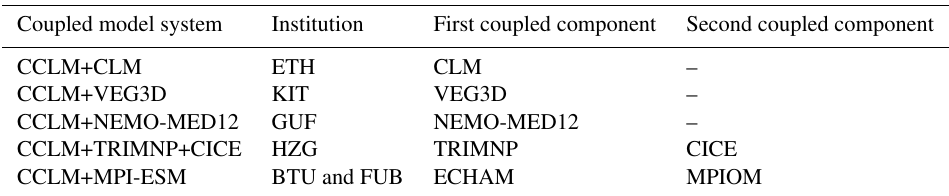
Table 2. Coupled model systems, their components and the institution at which they are maintained. For the meaning of the acronyms see Table 1. Coupled model